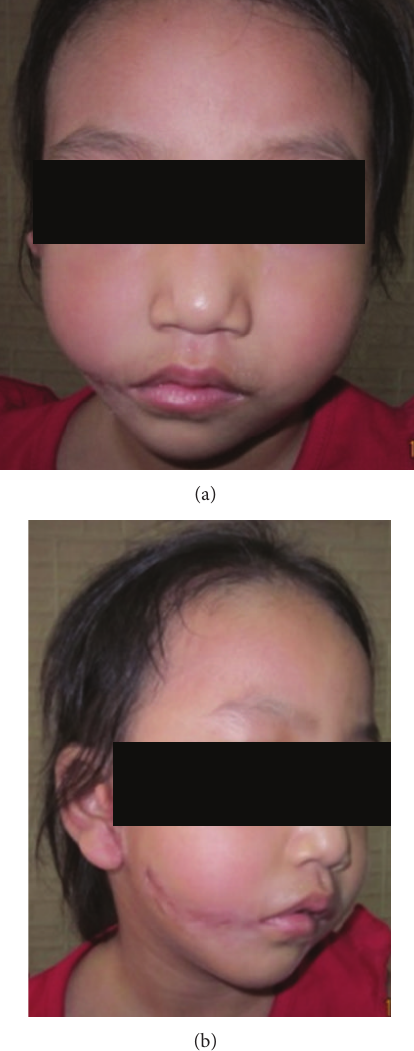
Figure 5: Postoperative frontal and lateral